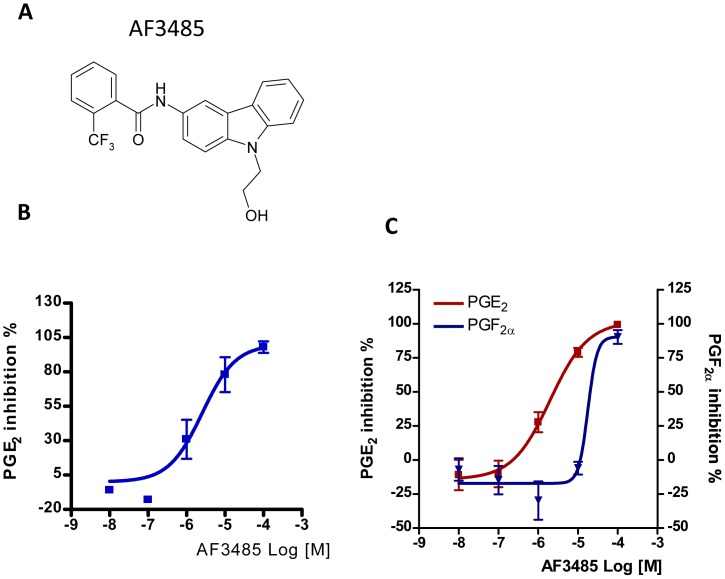
AF3485 inhibits human recombinant mPGES-1 activity in vitro and selectively inhibits IL-1β-induced PGE2 production in A549 cells.Structure of AF3485 (A). Effect of AF3485 (B) on hmPGES-1 expressed in bacterial membrane. A549 cells pre-treated with IL-1β (10 ng/ml, 18 h) then treated with AF3485 (C) (0.01–100 µM, 30 min). PGE2 and PGF2α levels measured by ELISA. Data reported as % inhibition of PGE2 (□) or PGF2α levels (▿).